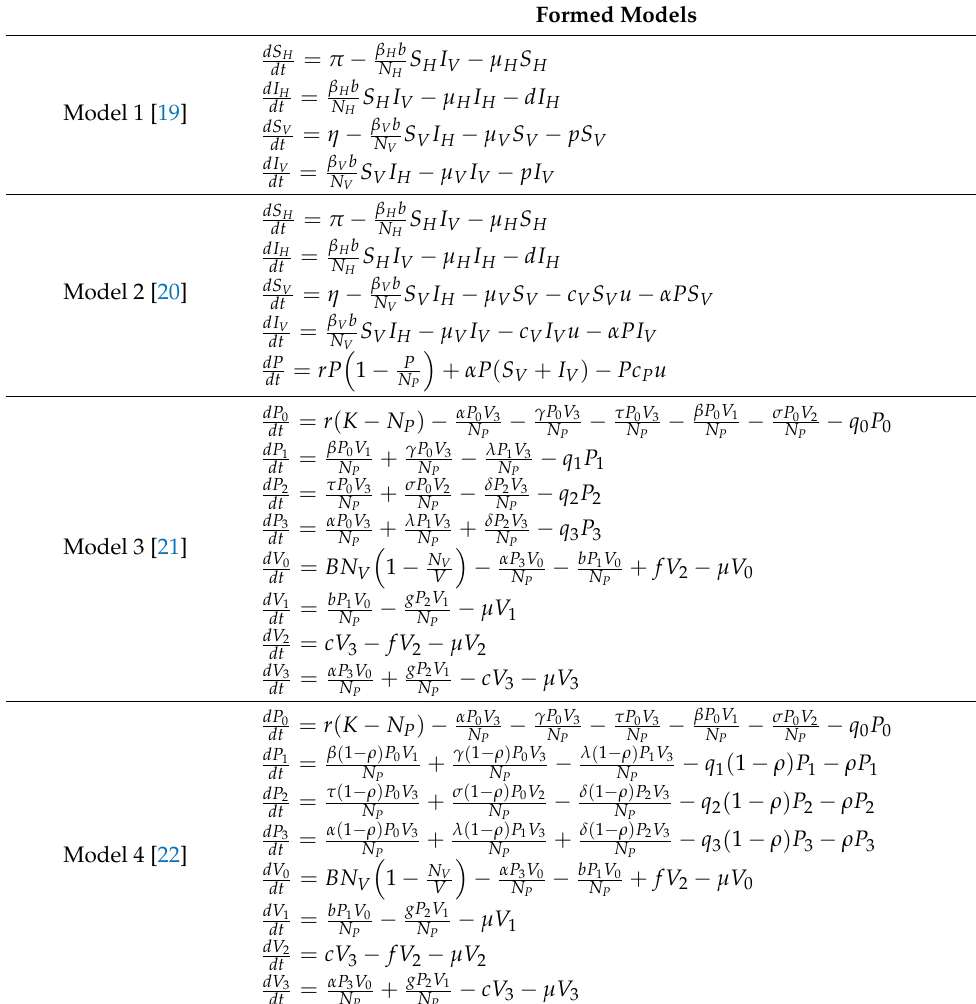
Table 3. Previous Tungro Disease Spread